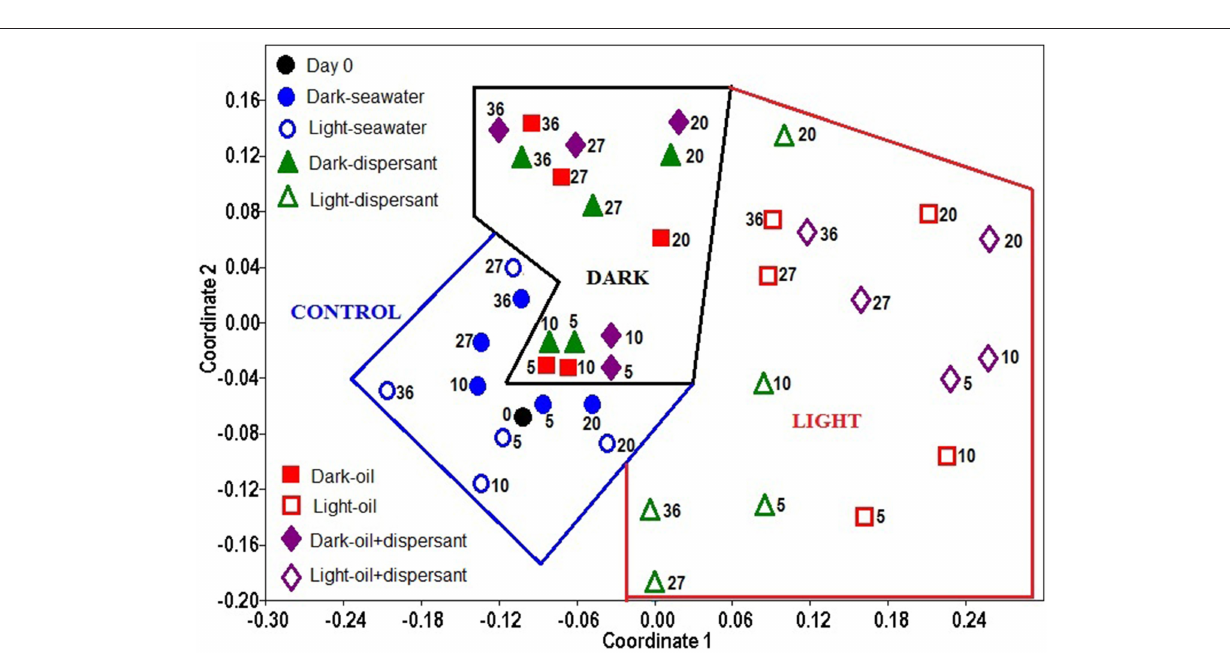
and in the presence of oil, dispersant, or oil+dispersant ( p = 0.0001) ( Table 2 ). ANOSIM also revealed that seawater